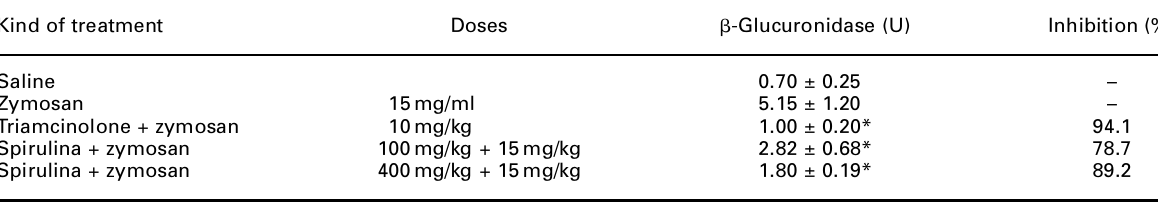
Table 1. Effect of Spirulina on b -glucuronidase activity in mice knee joint synovial fluid Kind of